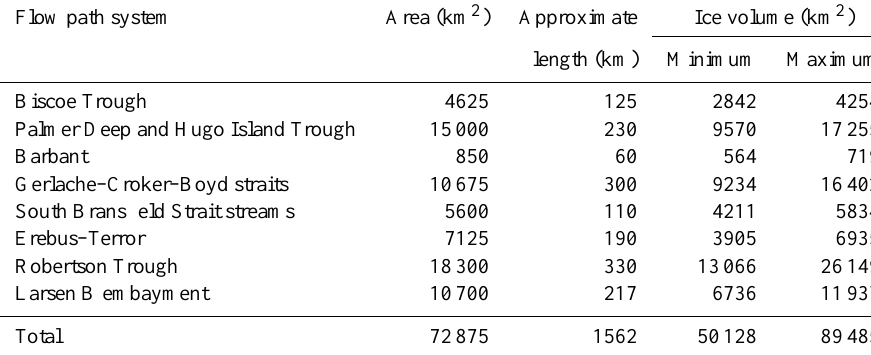
Figure 8. Range of ice thickness expected from (a) Marr (M), Livingston (L), Brabant (B), and Hugo (Hu) west AP continental-shelf domes with ice temperature averaging 0 ◦ C and (b) Robertson (R), Hektoria (H), and Snow Hill (SH) east AP continental-shelf domes with ice averaging − 20 ◦ C using the Bodvarsson–Vialov model (Bueler et al., 2005). The blue dot is the modern analog, 1000m thick Siple Dome in West Antarctica that fits well the model. See Fig. 5 for the location of the domes. Table 3. Flow path systems estimated area (continental shelf) and minimum and maximum estimated ice